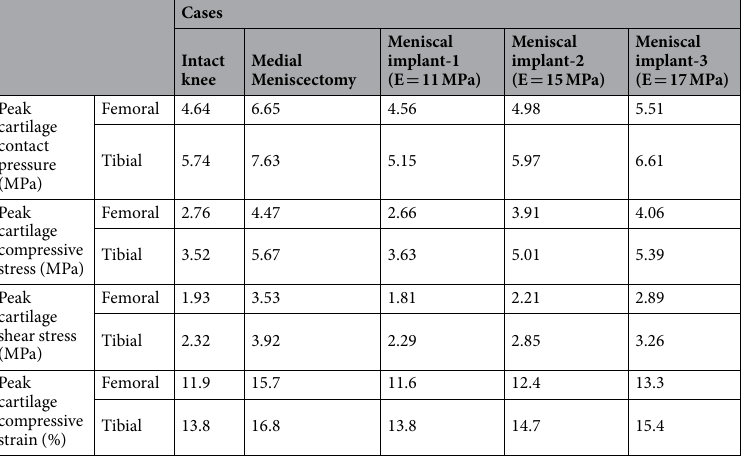
Table 3. Comparison of the peak cartilage contact pressure, the peak cartilage compressive stress, the peak cartilage shear stress, and the peak cartilage compressive strain induced on the articular cartilage of the models